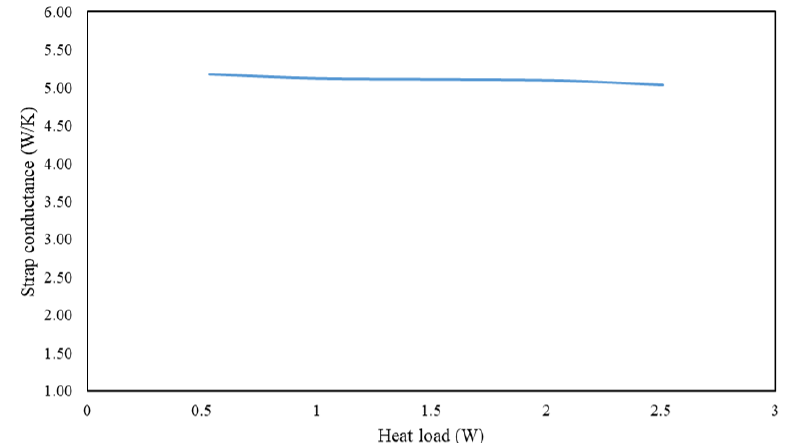
Figure 4. Thermal strap